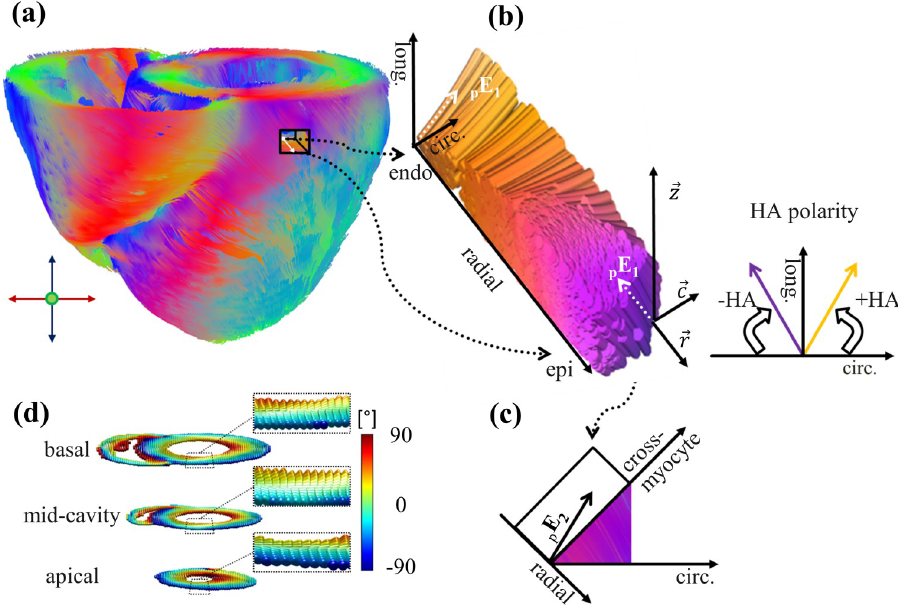
Fig 2. Orientation of primary and secondary eigenvector of diffusion and derived metrics helix angle and E2A. (a) Main eigenvector of diffusion mapped onto fiber tractography of the left and right ventricle. (b) Cut transmural block of reconstructed fibers from a) used to illustrate the parameter helix angle and assignment of its polarity within the local coordinate system of longitudinal z ! , radial r ! and circumferential c ! axes. (c) Projected secondary eigenvector angle. (d) Tensor visualization as superquadric glyphs in basal, mid-cavity and apical parts of (a). Color coding resembles helix angle values for single voxels. Zoomed areas show the typical smooth progression of positive right handed fibers in the endocardium to negative left handed fibers in the